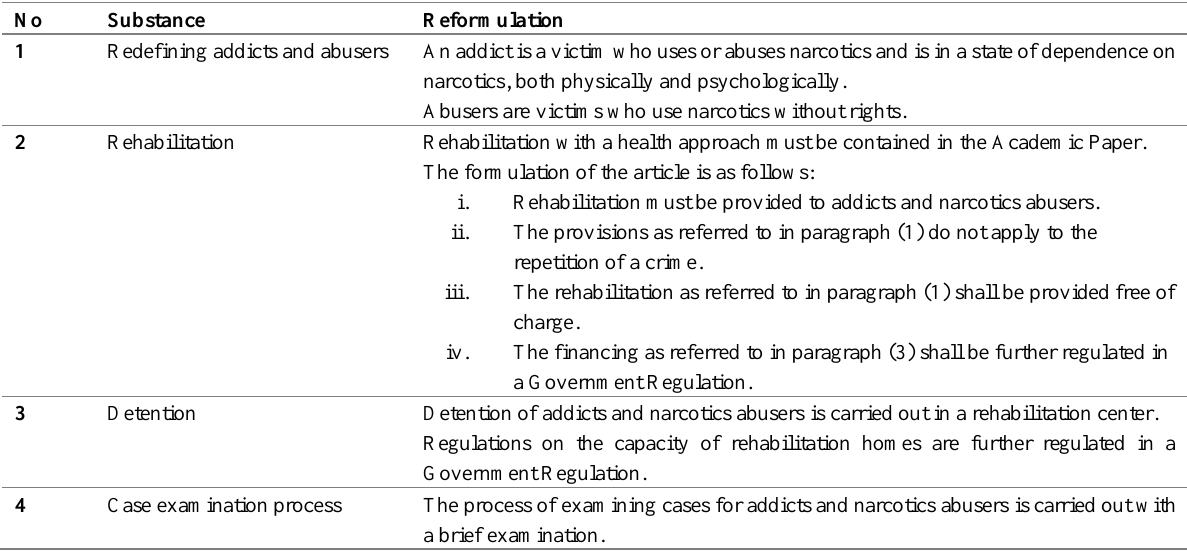
Table 2: Reformulation of